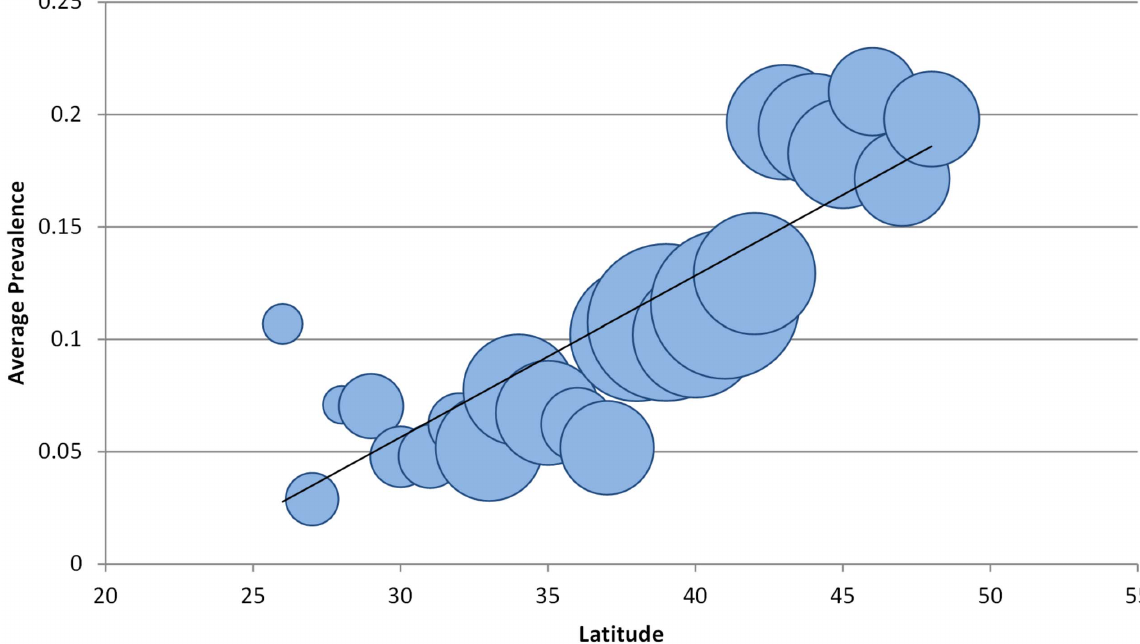
PLOS ONE | www.plosone.org 5 August 2014 | Volume 9 | Issue 8 |